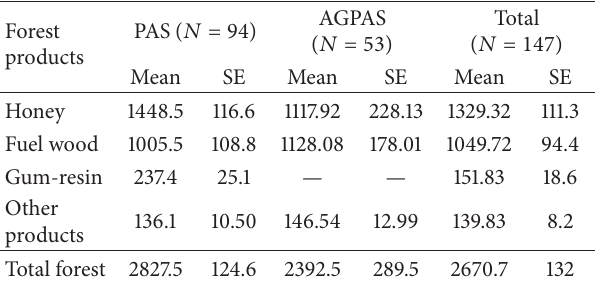
Table 1: Mean annual household income (in ETB) from different forest